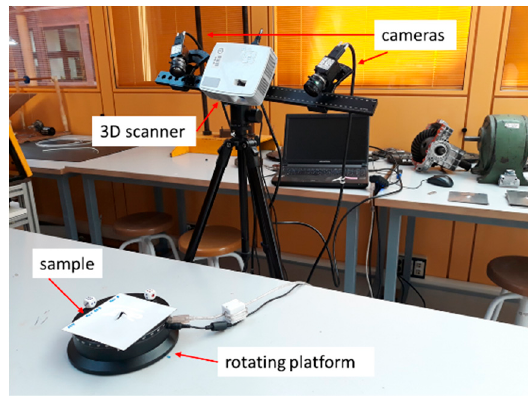
Figure 13. HP 3D scanner test.